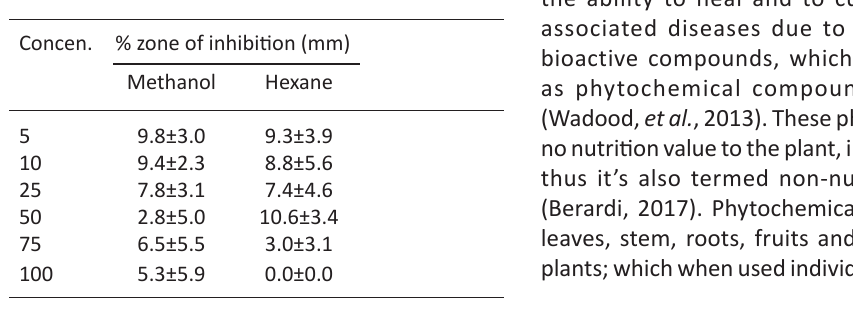
Table 11. Results obtained from the ANOVA analysis for methanol and hexane extracts for C. cinereum at 100%, 75%, 50%, 25%, 10% and 5% concentration against K. pneumoniae ANOVA